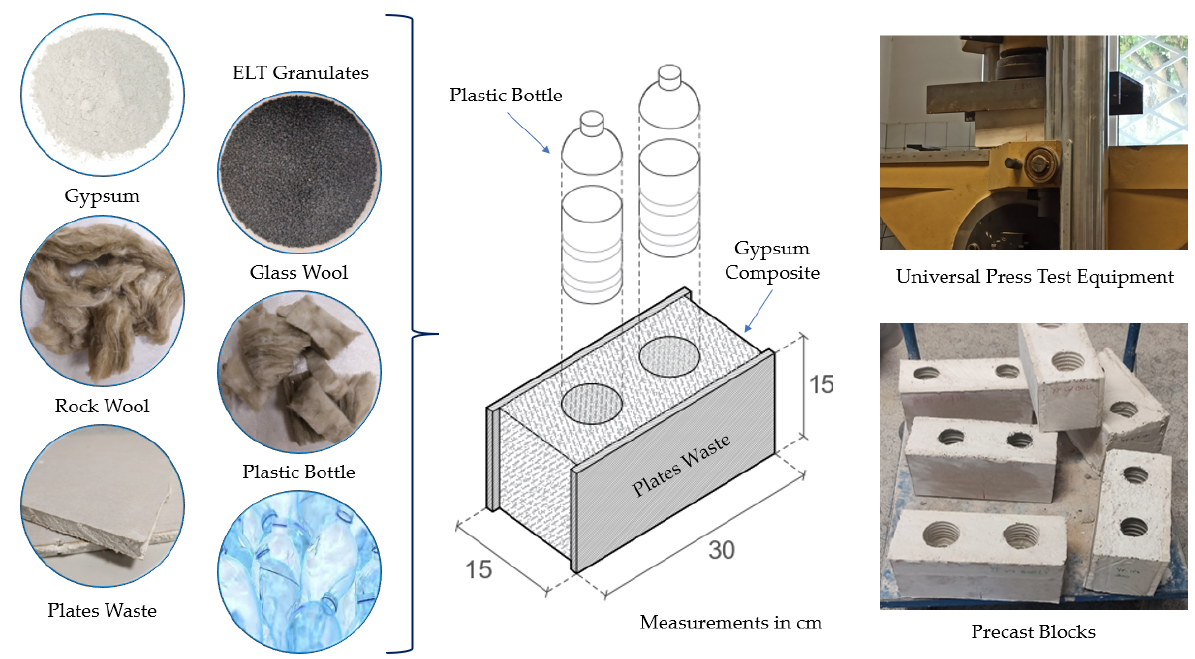
Figure 11. Process of elaboration and testing of the prefabricated blocks elaborated for this research.